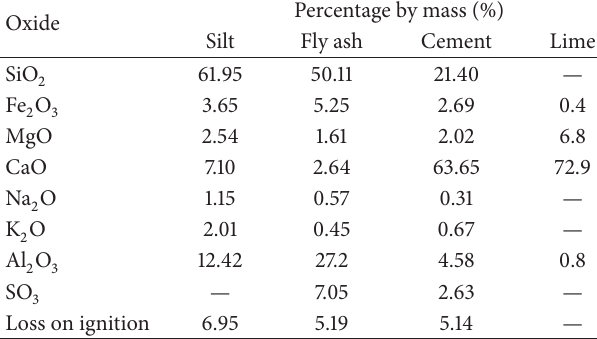
Table 2: Chemical compositions of materials.